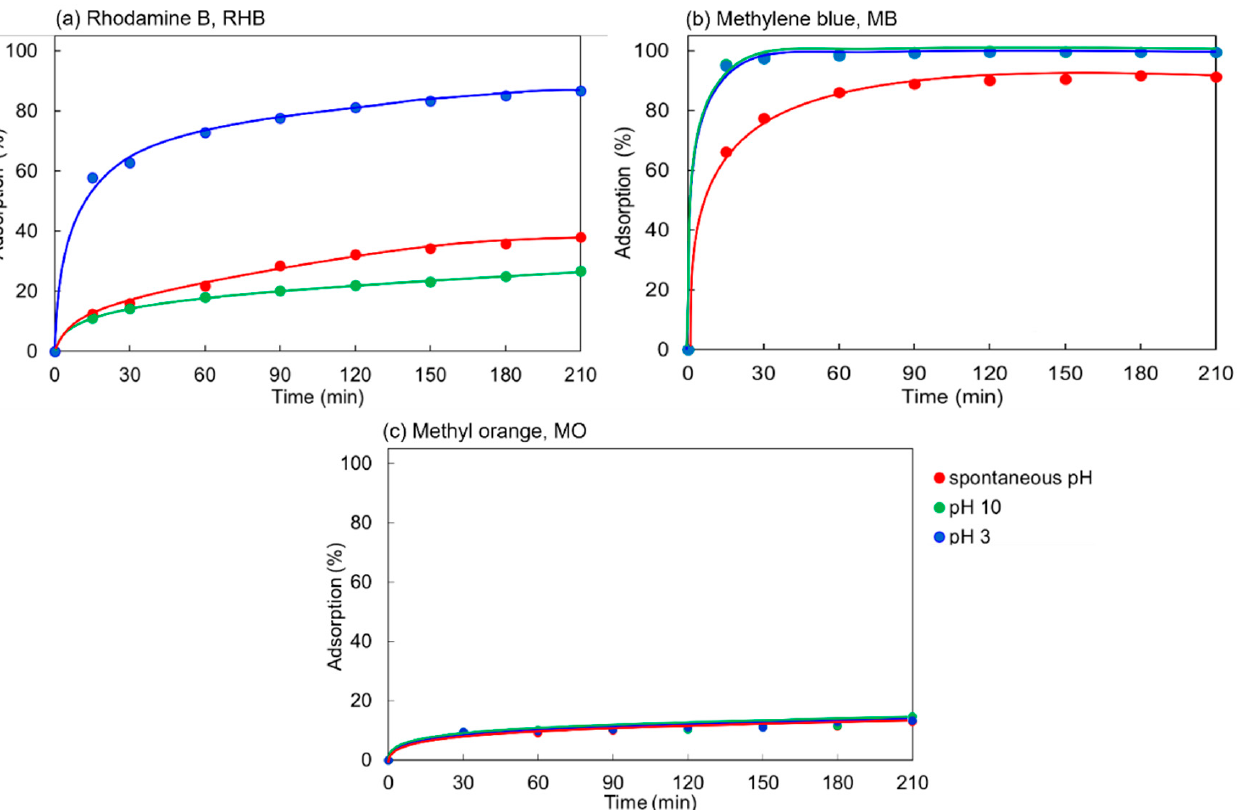
Figure 6. Effect of initial pH on the adsorption properties of LS towards ( a ) RHB, ( b ) MB, and ( c ) MO.